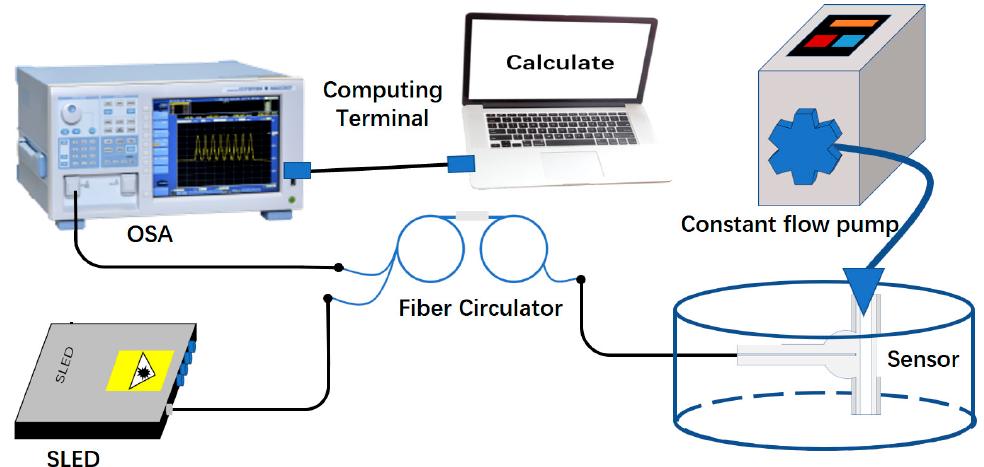
Figure 4. The experimental setup for RI measurement. Table 3. The relationship between the concentration and the RI of KCl solutions. The Concentration of the Solution The RI of the Solution